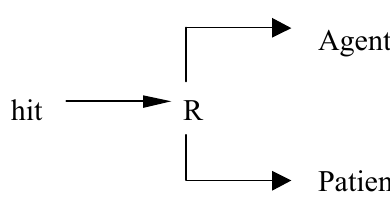
Relational Roles between Lexical Items R = role (Adapted from MacWhinney, 1987, p.